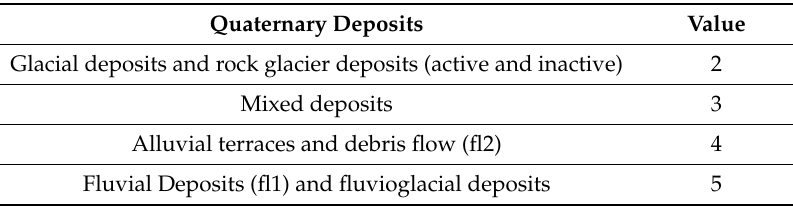
Table 3. Classification of quaternary deposits in the Sesia ValGrande UGG. Quaternary Deposits Value Glacial deposits and rock glacier deposits (active and inactive) 2 Mixed deposits 3 Alluvial terraces and debris flow (fl2) 4 Fluvial Deposits (fl1) and fluvioglacial deposits